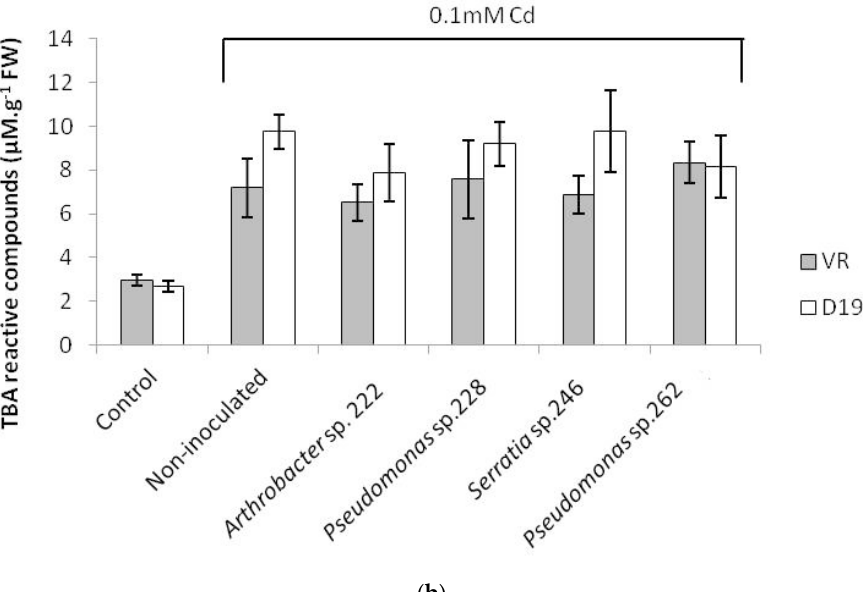
Figure 2. Thiobarbituric acid reactive compounds (µM·g − 1 fresh weight) in roots of H. tuberosus cultivars VR and D19 after three weeks of exposure to: 1 mM of Zn ( a ); and 0.1 mM Cd ( b ). * Significant differences between inoculated and non-inoculated after Tukey’s test, p < 0.05; mean values ± SE; n = 4.